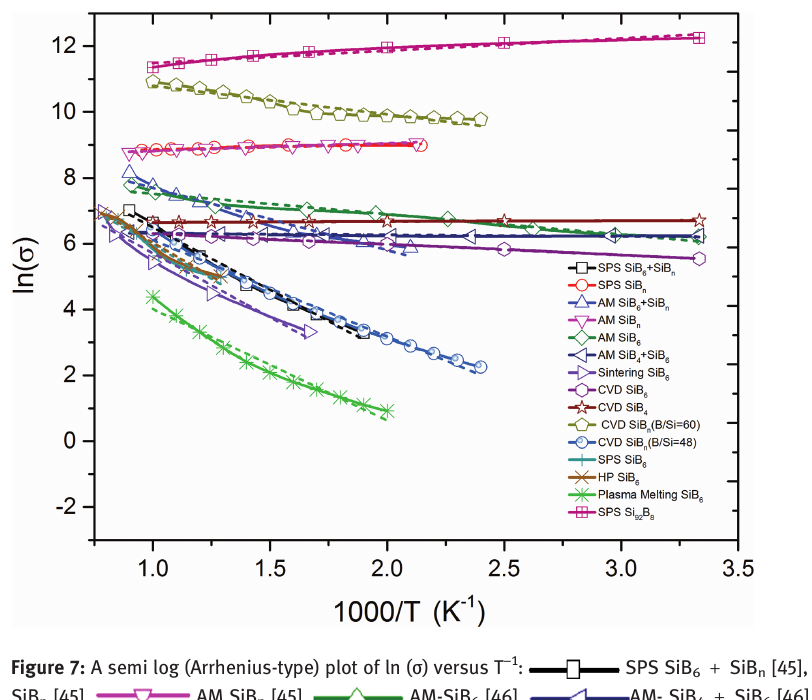
Figure 7: A semi log (Arrhenius-type) plot of ln ( σ ) versus T − 1